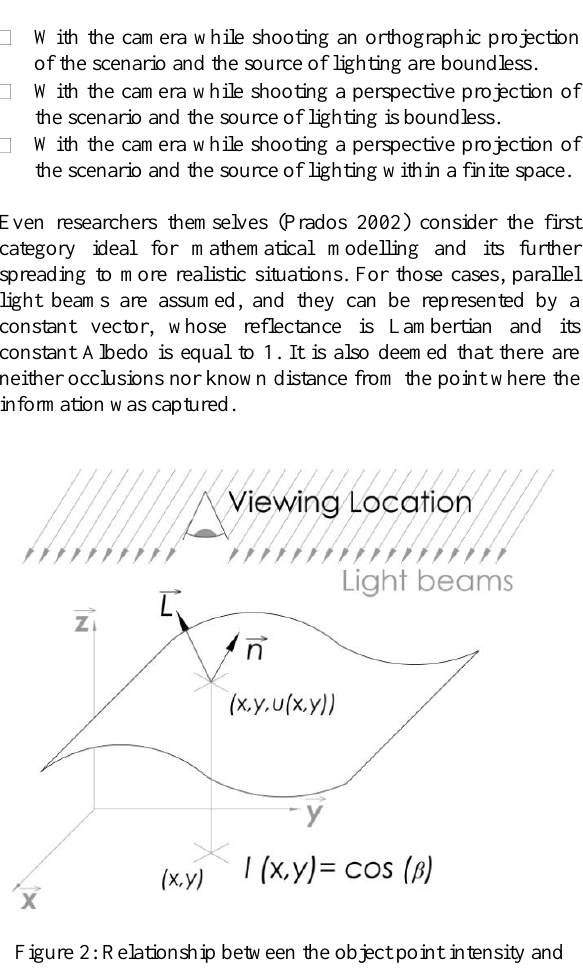
Figure 2: Relationship between the object point intensity